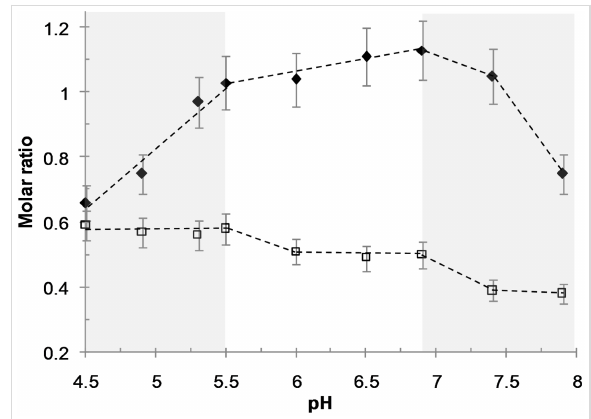
Figure 5: Molar ratio N/AA (filled triangles) and EO/Si (open squares) of the hybrid materials synthesized at 3.9 wt % DHBC as a function of